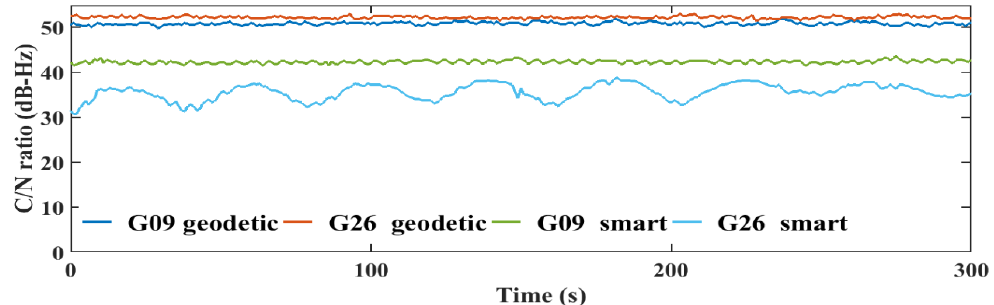
Figure 9. L5 C/N values from the geodetic receivers (geodetic) and the smartphone (smart) for GPS.